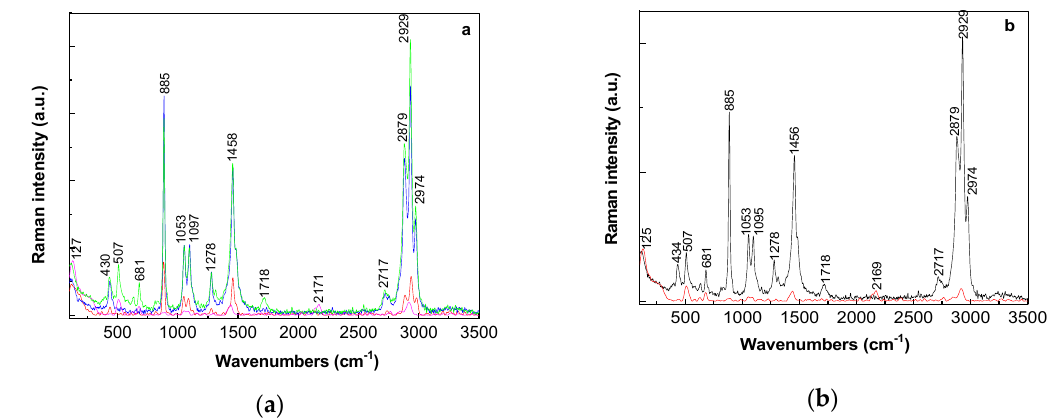
Figure 10. Raman spectra of the ALA layer deposited onto metallic films prepared using 1 mL (red curve), 2 mL (blue curve), 4 mL (magenta curve), and 6 mL (green curve) colloidal solutions of Au nanoparticles with a size of 50 nm ( a ). The dependence of the intensity of Raman spectra on the ALA layers deposited onto metallic films prepared from 6 mL colloidal solutions of Au nanoparticles with sizes of 50 nm (black curve) and 10 nm (red curve) ( b ). In all samples, the ALA solution concentration was 10 − 2